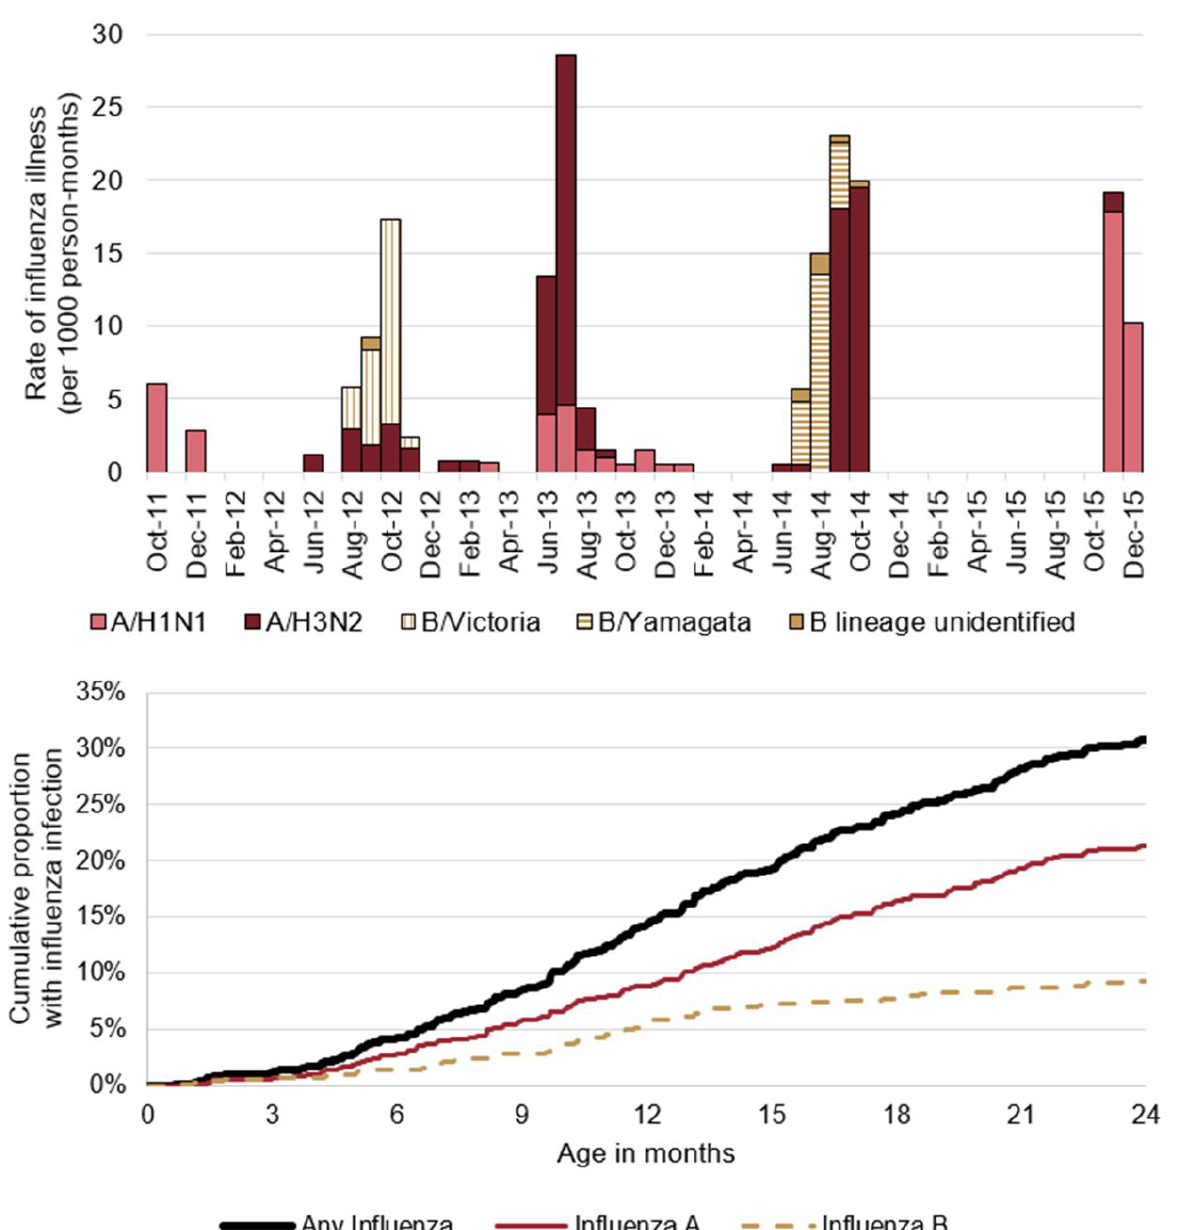
Figure 1. Monthly rates of influenza illness (upper panel), and cumulative proportion of influenza illness among infants <2 years of age in Managua, Nicaragua, 2011–2015 (lower panel). One A/H3N2-B/Yamagata co-infection during September 2014 is not portrayed.